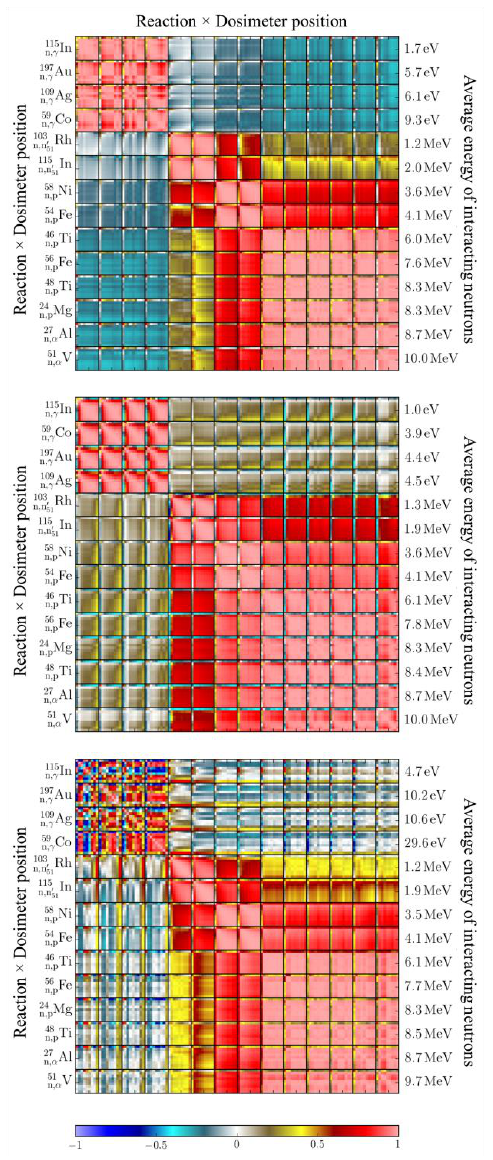
Fig. 5. Correlation matrices of reaction rates for all considered dosimetry reactions in the elemental reflectors (Fe, Cr and Ni, top to bottom), sorted by lethargy-averaged neutron energy and dosimeters position (“pixels” within each reaction) .